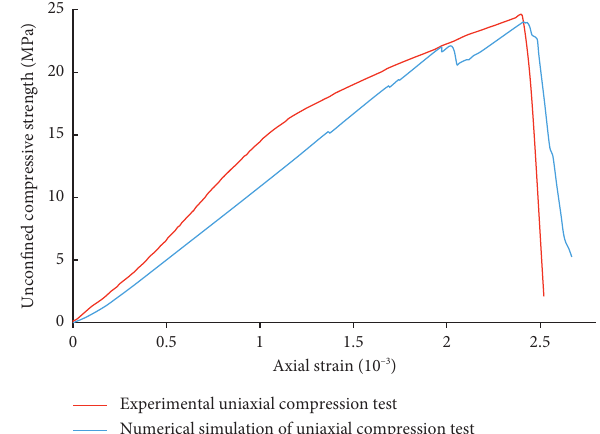
Figure 4: Experimental and numerical stress-strain curves of uniaxial compression tests.